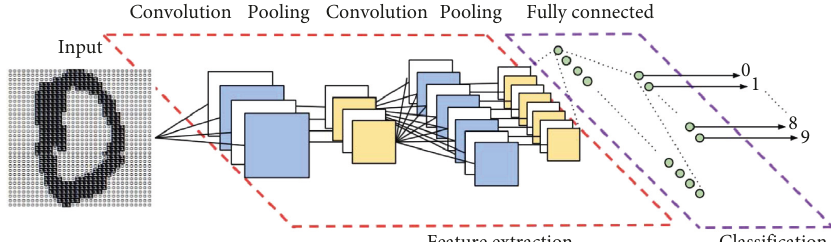
Figure 2: Example of CNN and its layers. Image adapted from Vargas et al. [23].